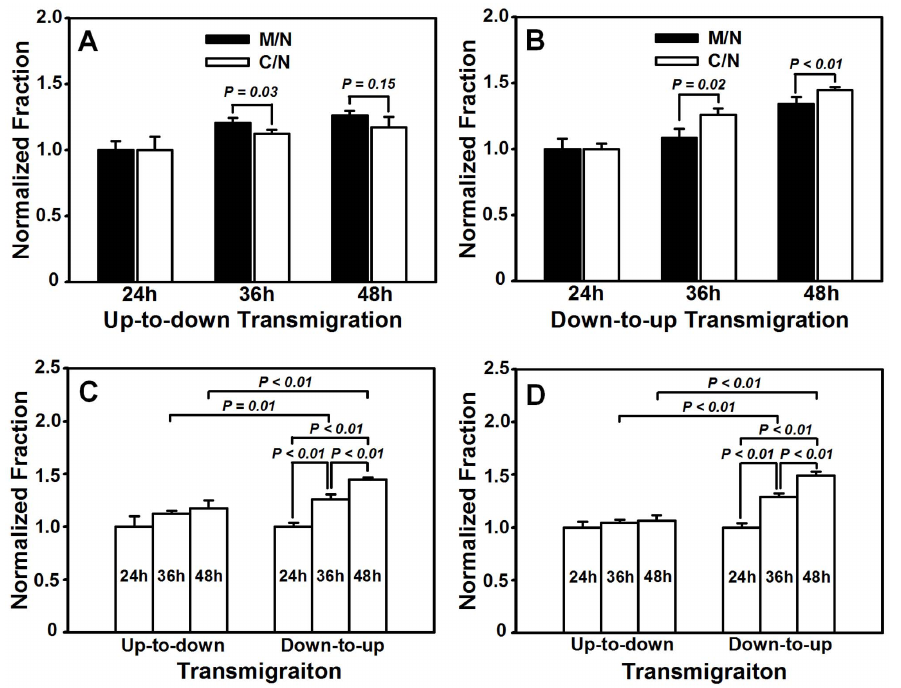
Figure 5. Transmigration of HaCaT cells on collagen I-coated transwell chamber. ( A, B ) Up-to-down ( A ) or down-to-up ( B ) transmigration of monoclutured or cocultured HaCaT cells in the absence of mechanical stretch. ( C , D ) Up-to-down or down-to-up transmigration of cocultured HaCaT cells in the absence ( C ) or presence ( D ) of mechanical stretch. Data are presented as the fraction of transmigrated HaCaT cells at t =36, 48 h normalized to that at t =24 h in respective cases.